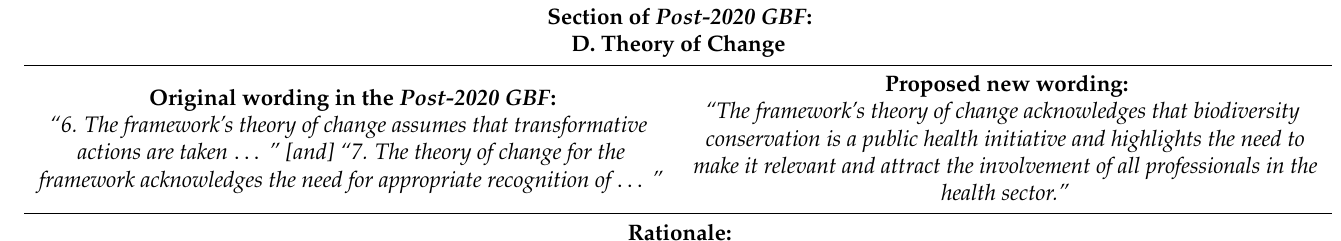
Table 1. Suggested revised health-inclusion statement and rationale for “Section D. Theory of Change” within the Post-2020 GBF .